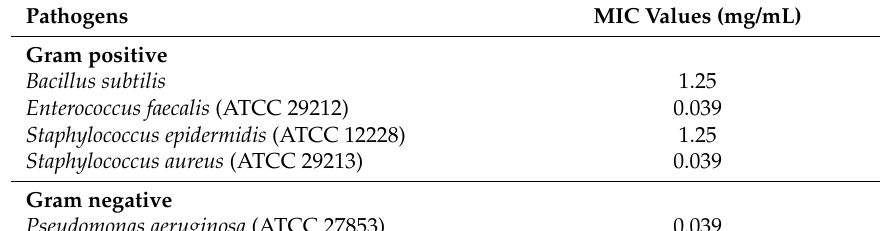
Figure 9. Antibacterial activity of the silver nanoparticles derived from marine Streptomyces sp. Al-Dhabi-87. ( A ) Bacillus subtilis ; ( B ) Staphylococcus aureus . Table 1. In vitro antimicrobial activities of silver nanoparticles derived from marine Streptomyces sp. Al-Dhabi-87.